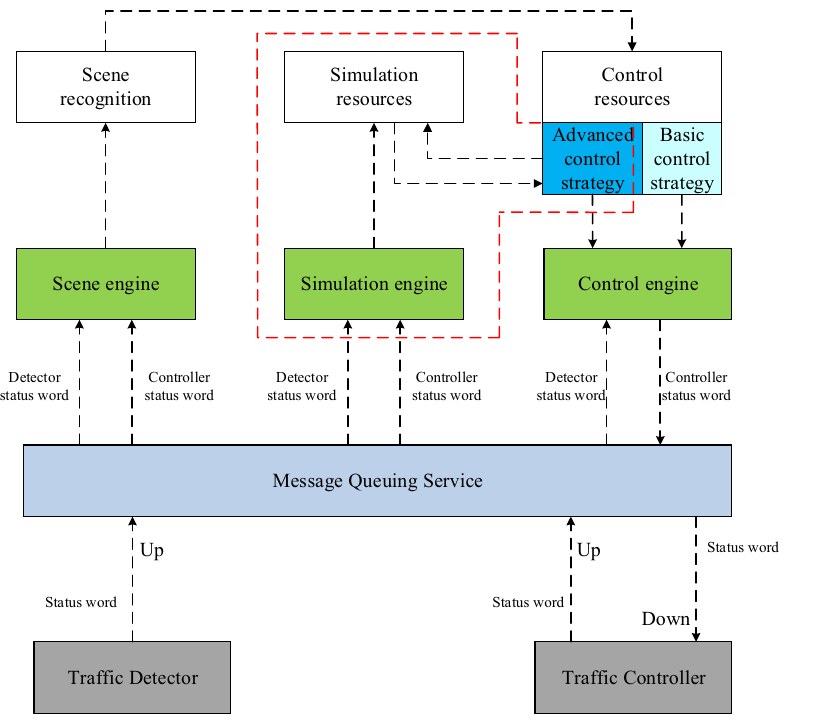
Figure 2. Traffic control simulation integrated platform data